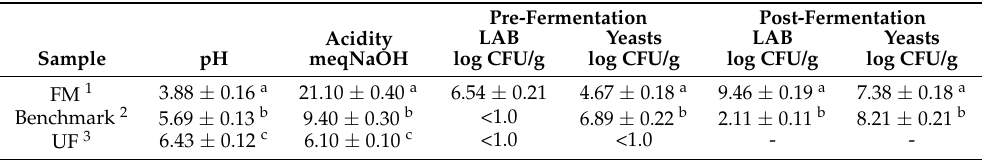
Table 2. pH, titratable acidity, LAB and yeast cell load (pre- and post-fermentation) of the different samples after 24 h of fermentation. For the same parameter, average values lacking a common letter ( a–c ) significantly differ from each